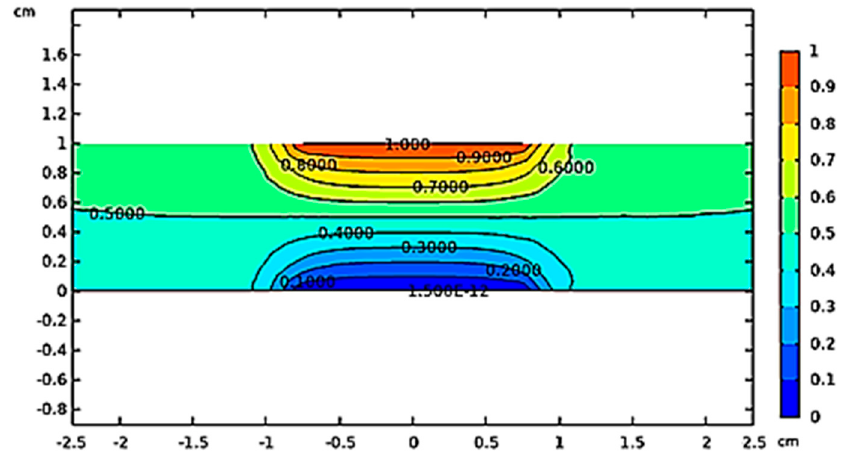
Figure 6. Profile of the electric potential (V) in the capacitive structure.